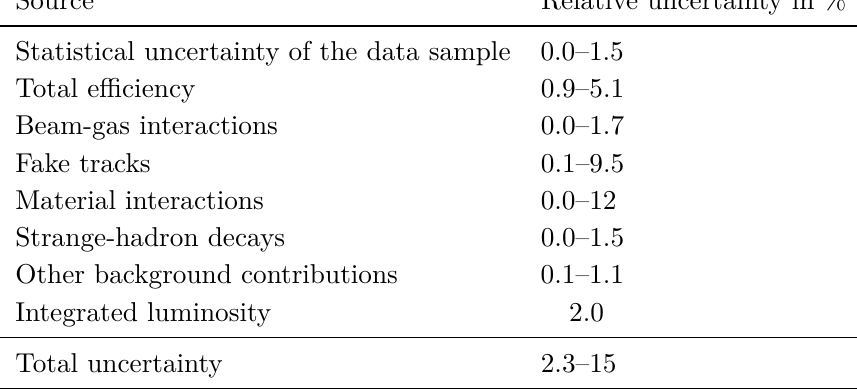
Table 1 . Statistical and systematic uncertainties affecting the measured differential cross-section.